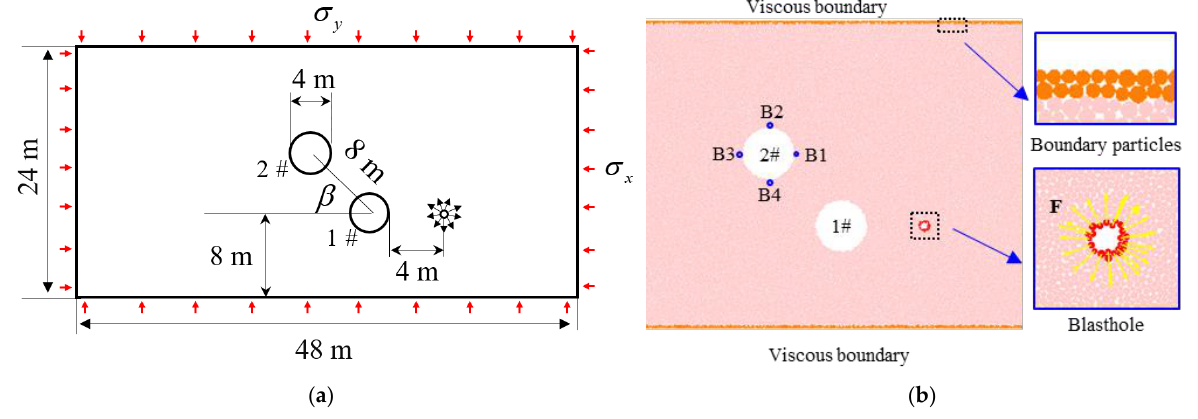
Figure 4. Schematic diagram of numerical models: ( a ) numerical model design scheme; ( b ) measuring circles setting and partial numerical model (1#—adjacent tunnel, 2#—non-adjacent tunnel).